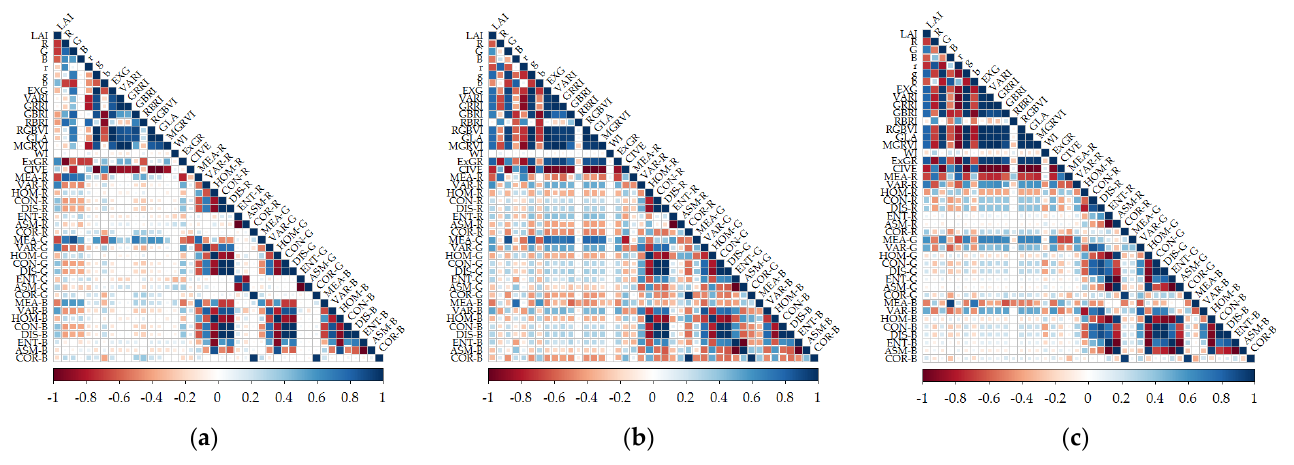
Figure 4. Correlation between UAV image characteristic parameters and LAI at different growth stages. ( a ) Initial flowering stage (IF); ( b ) young fruit stage (YF); ( c ) fruit enlargement stage (FE).